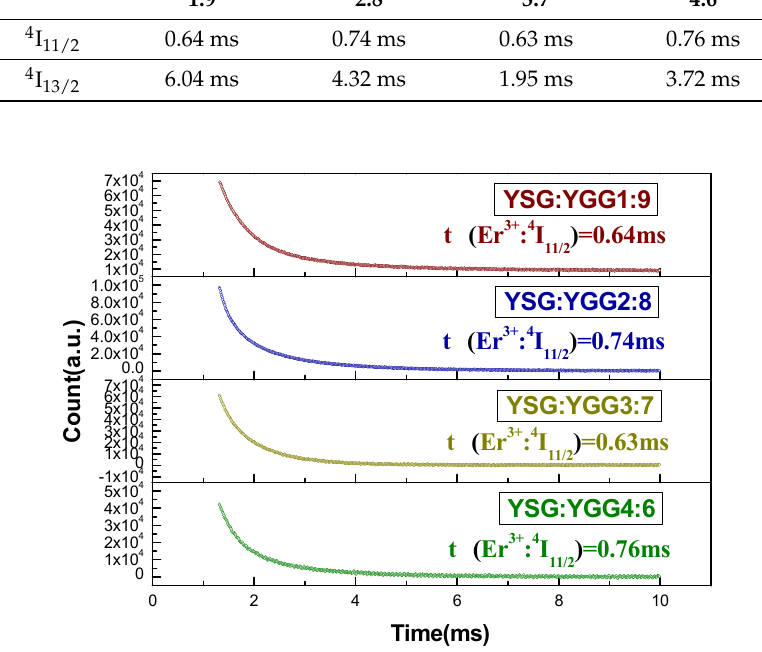
Figure 7. Decay curves of Er 3+ : 4 I 11/2 levels in samples of YSG:YGG 1:9, 2:8, 3:7 and 4:6.